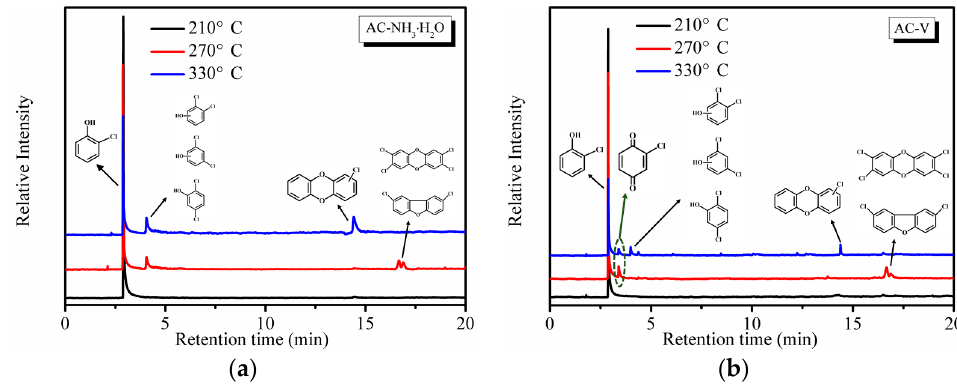
Figure 8. Online GC ‐ MS measurements for o ‐ CP oxidation over ( a ) AC–NH 3 ∙ H 2 O and ( b ) AC–V Figure 8. Online GC-MS measurements for o -CP oxidation over ( a ) AC–NH 3 · H 2 O and ( b ) catalysts. AC–V